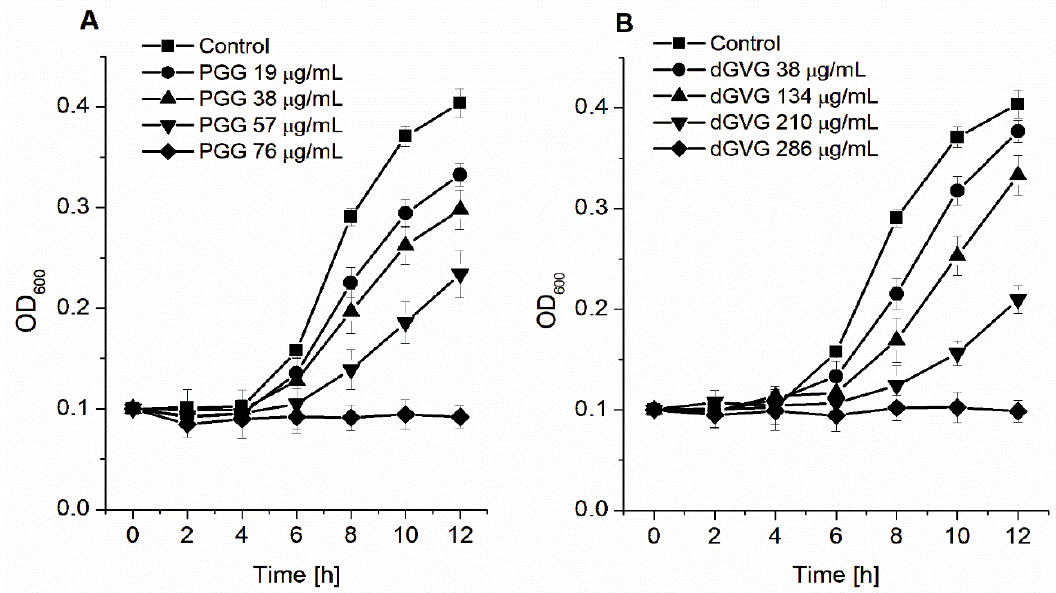
Figure 1. Growth curves of S. aureus 8325-4 in the presence of PGG ( A ) and dGVG ( B ). The data presented are the means ± SD, n = 6.